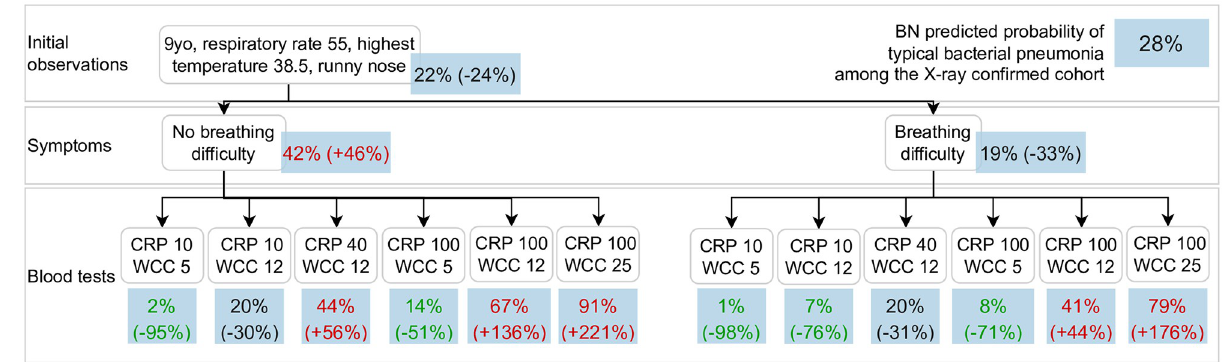
Fig 10. Clinical scenario 2, BN v4.5. This scenario presents a school-aged ( age group (1) ) child with X-ray confirmed pneumonia and with moderately high temperature ( highest temperature (37) ), runny nose ( rhinorrhoea (31) ) and high respiratory rate (53) . The BN predicts a 22% probability of typical bacterial pneumonia for this child ( causative pathogen for pneumonia (25) ), and this prediction increases to 42% if the child has no breathing difficulty (49) . Moderate and very high C-reactive proteins (55) and white cells count (56) further increase the probability of a typical bacterial cause for this